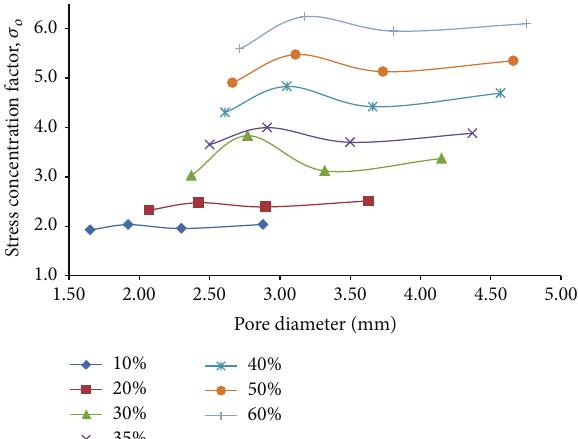
Figure 15: Plots depicting variation of stress concentration factor, 𝜎 𝑜 , against pore diameter for different percentages of porosity of 3D porous FE cantilever beam models subjected to combined loading action.